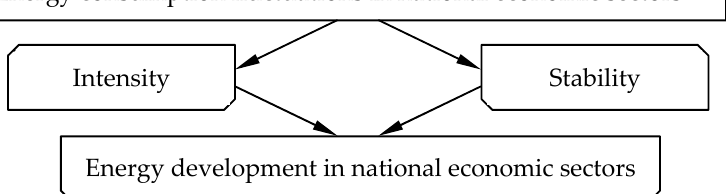
Figure 1. Model for quantitative evaluation of energy development in national economic sectors (source: compiled by the authors).